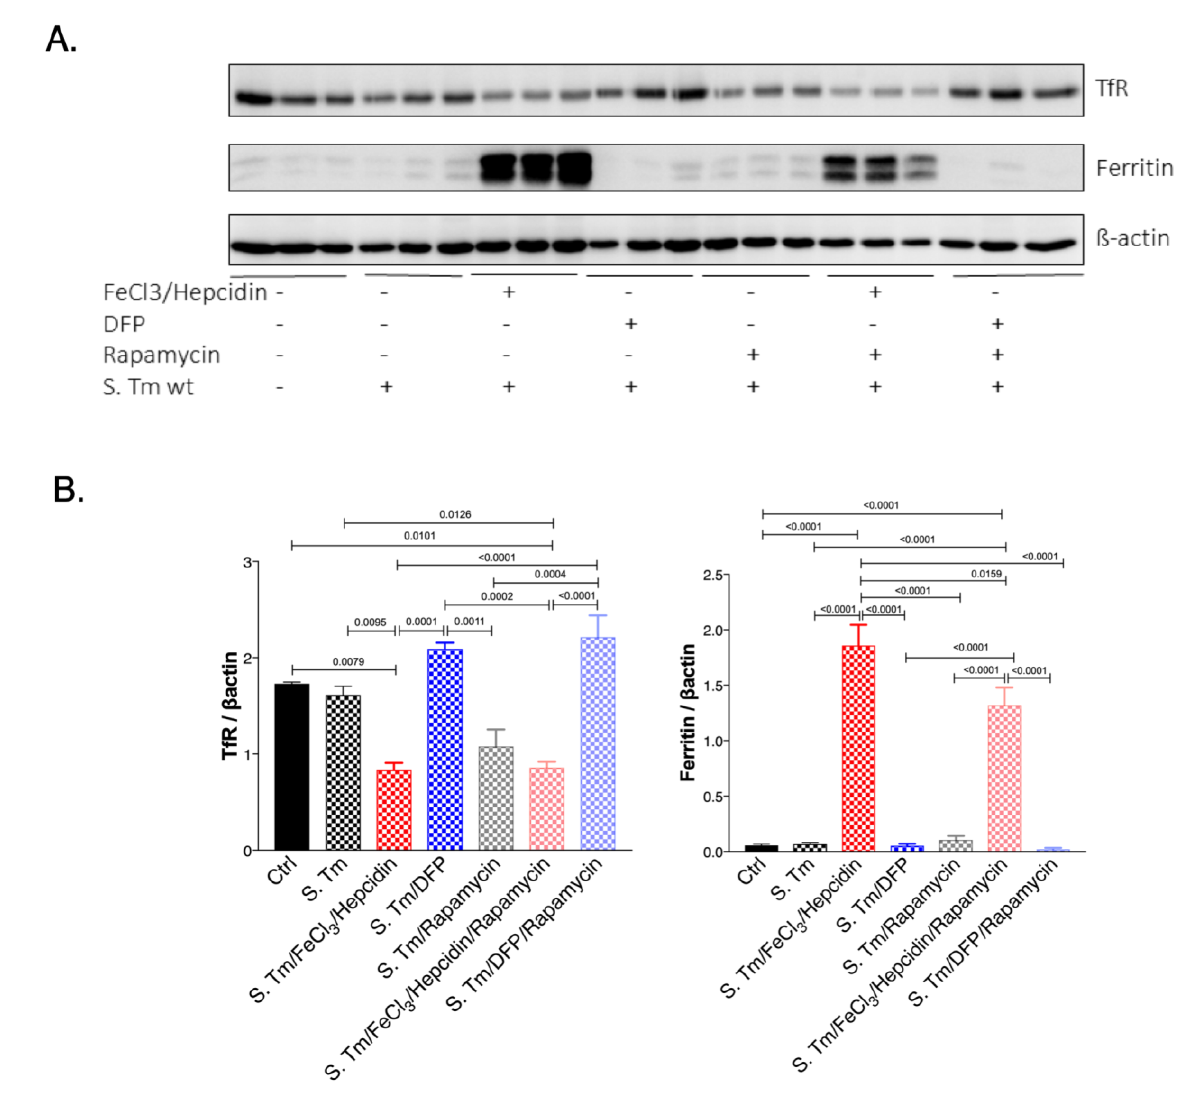
FIGURE 6: Effect of Salmonella infection, iron perturbation and mTOR inhibition on iron homeostasis in RAW264.7 cells. Protein levels of transferrin receptor (TfR) and ferritin were determined in control and Salmonella infected RAW264.7 cells after 24 hours of infection and either pretreatment with FeCl 3 /hepcidin or DFP and/or rapamycin for 6 or 1 hours respectively. Representative blots (A) and densitometric quantification of results relative to beta-actin expression (B) are shown. Graphs show means ± SEM. One- way ANOVA with Tukey’s multiple comparison correction was performed. Exact p-values (< 0.05) are indicated in the